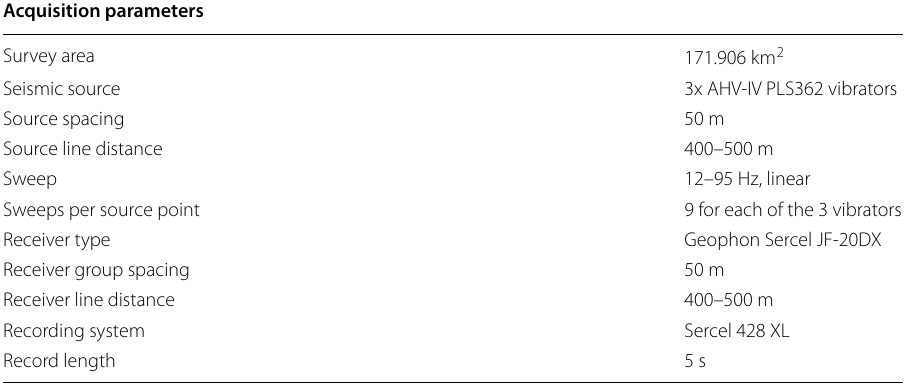
Table 1 Acquisition parameters of the GRAME 3D